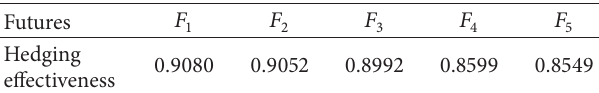
Table 5: Hedging effectiveness estimation of different-maturity futures